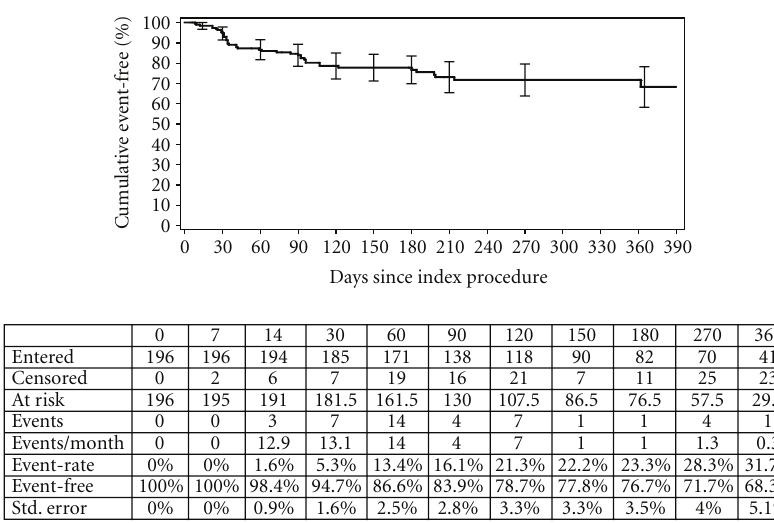
Figure 1: The Kaplan-Meier analysis of time to clinical failure on treated